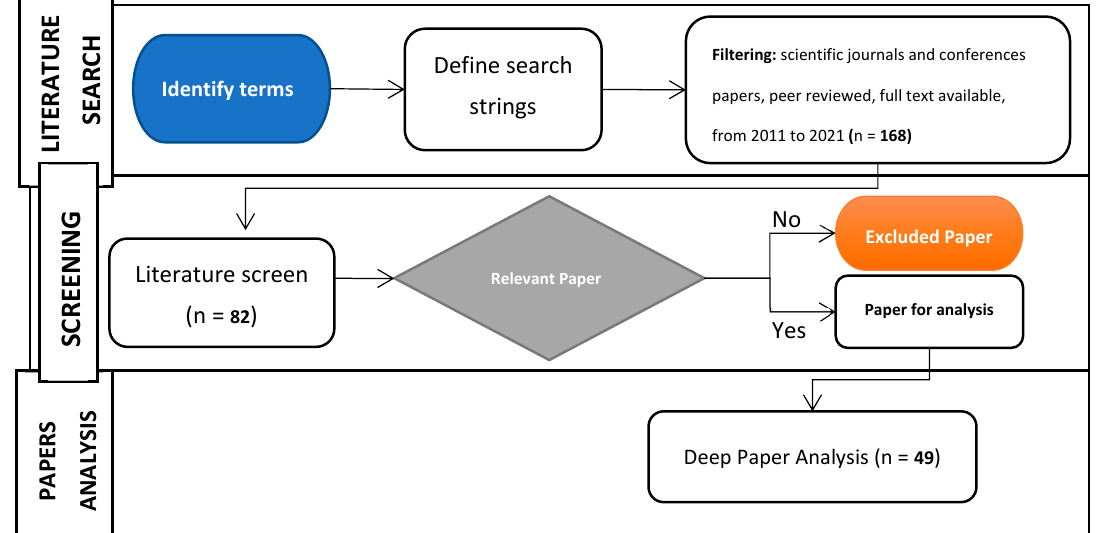
Figure 1. Applied SLR methodology.